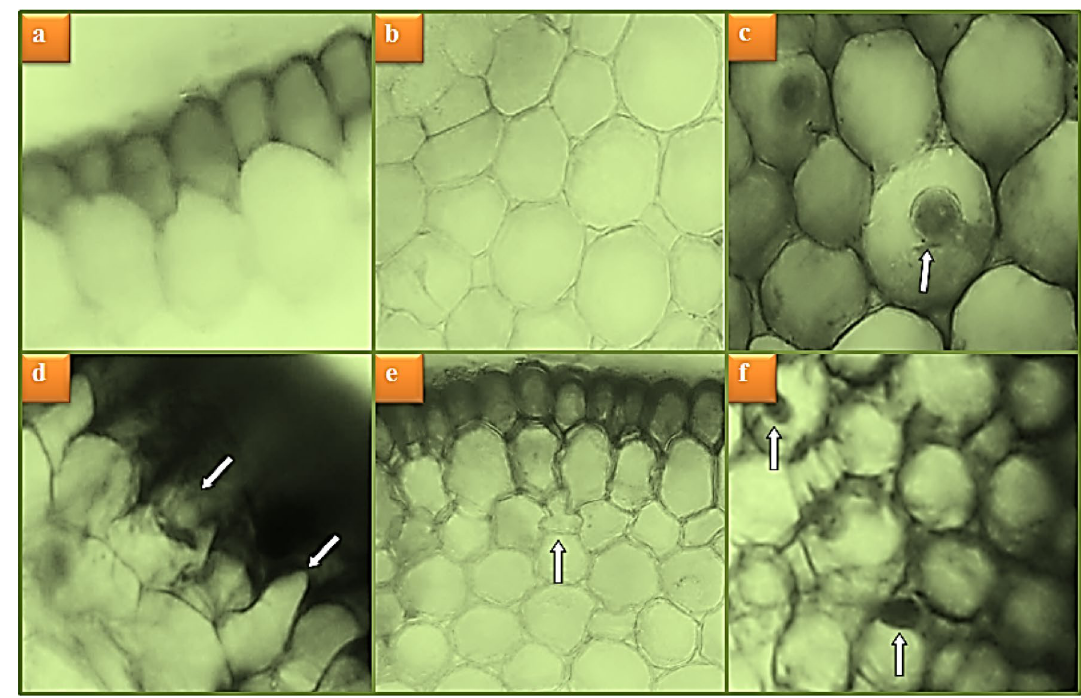
Figure 6. Meristematic cell damages induced by uranyl acetate. Normal appearance of epidermis cells ( a ), normal appearance of cortex cells ( b ), normal appearance of cell nucleus- oval ( c ), epidermis cell damage ( d ), cortex cell damage ( e ), flattened cell nucleus ( f ).